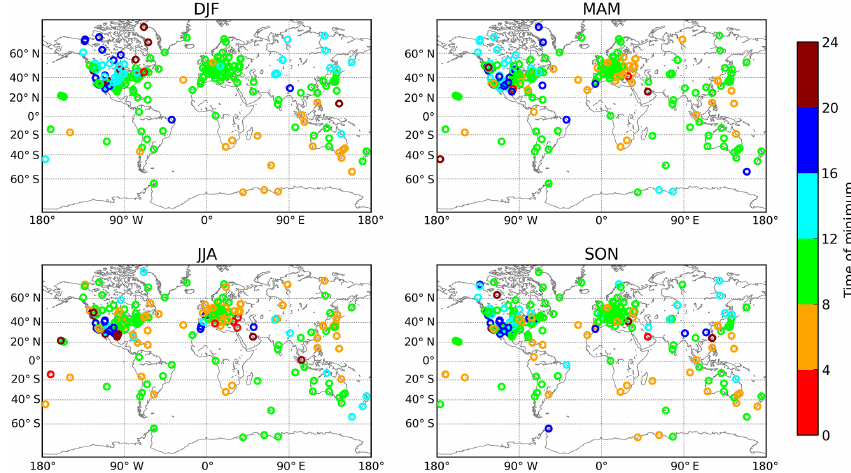
Figure 7. Local time of occurrence of the minimum of the seasonal-averaged daily